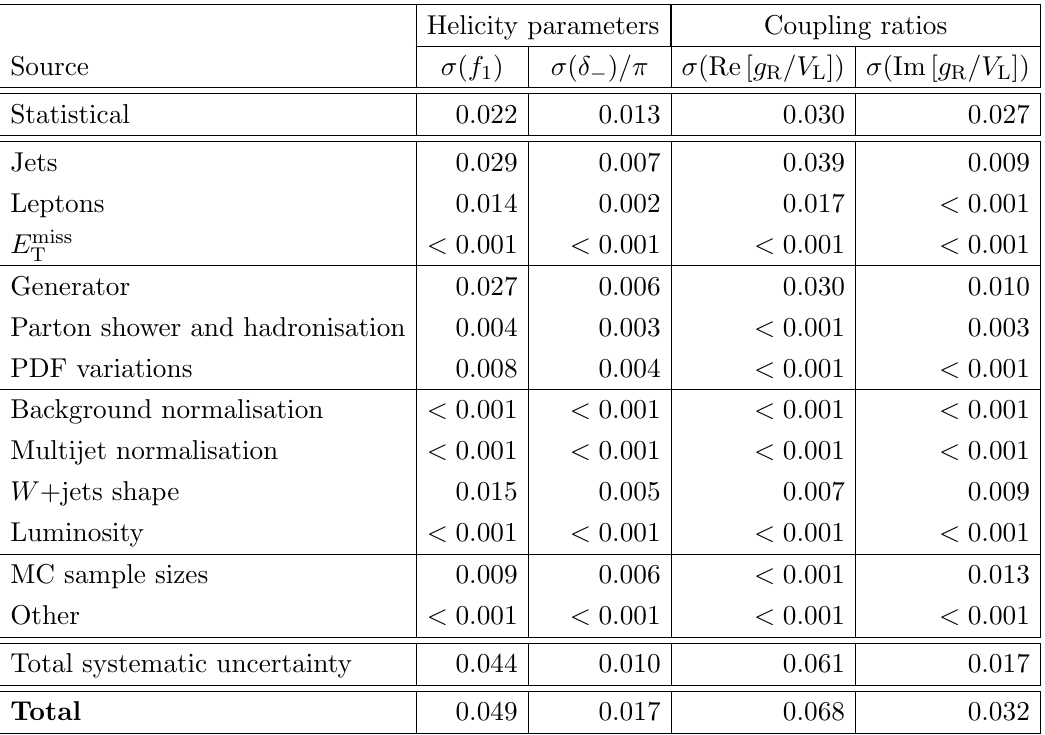
Table 2. Statistical and systematic uncertainties in the measurement of helicity parameters f 1 and (cid:14) , and of coupling ratios Re [ g R =V L ] and Im [ g R =V L ]. Uncertainties from individual sources are (cid:0) estimated separately for shifts up and down, and symmetrised uncertainties (cid:27) ( f 1 ) and (cid:27) ( (cid:14) (cid:27) (Re [ g R =V L ]) and (cid:27) (Im [ g R =V L ]) are given. The statistical uncertainty is calculated by evaluating the likelihood including only the covariance matrix, V , arising from the data statistics. The total uncertainty is calculated by including V syst in the likelihood calculation as well as V . Finally, the total systematic uncertainty is computed by subtracting in quadrature the statistical uncertainty from the total